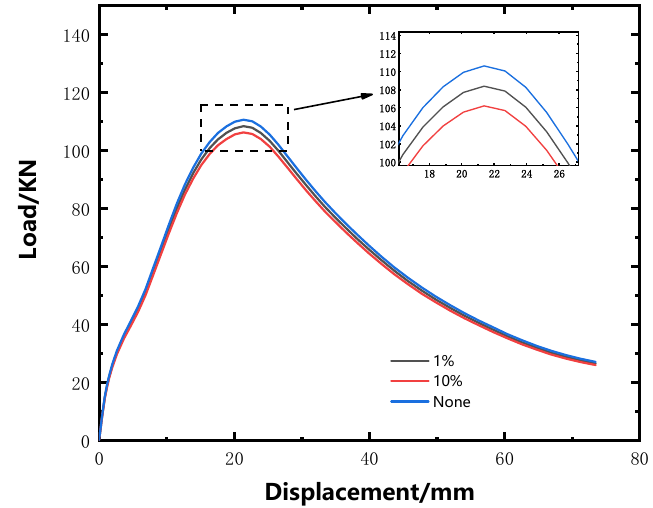
Figure 13. The load-displacement curve. In the absence of disturbance, when the load in the load-bearing area of the load- bearing assembly reaches the critical load of nonlinear buckling, the displacement and deformation in the load-bearing area is 21.4 mm, and the corresponding stress situation is shown in Figure 14. The stress range on the load-bearing surface is 292.4~467.8 Mpa, which is less than the yield strength of the material; the stress in some areas reaches 701.7 Mpa, which exceeds the tensile strength of the material. At this time, the structure gradually loses stability. Since then, under the continuous load, the bearing capacity of the bearing area has decreased significantly, and the structure has entered the unstable state, which shows that it is necessary to consider the nonlinear buckling analysis.